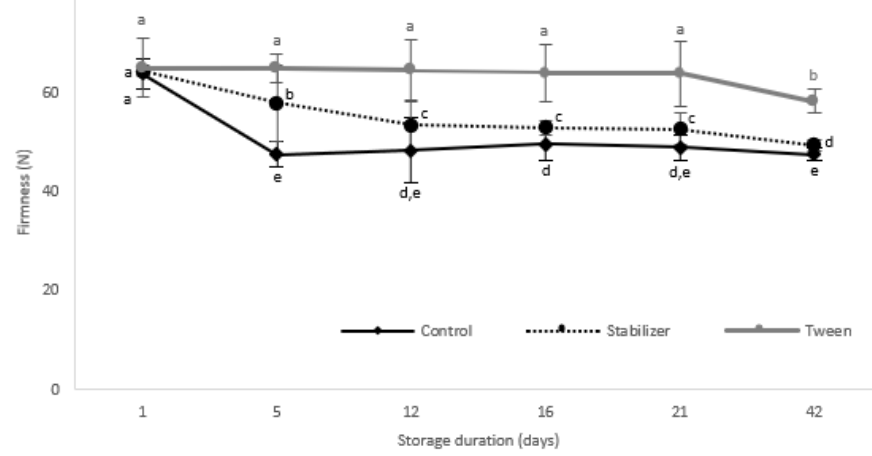
Figure 5. Firmness of coated zucchinis during storage. The data are mean ± SD of three replicates from two zucchinis. Different letters indicate significant differences with ANOVA and Tuckey post-hoc test at p < 0.05.